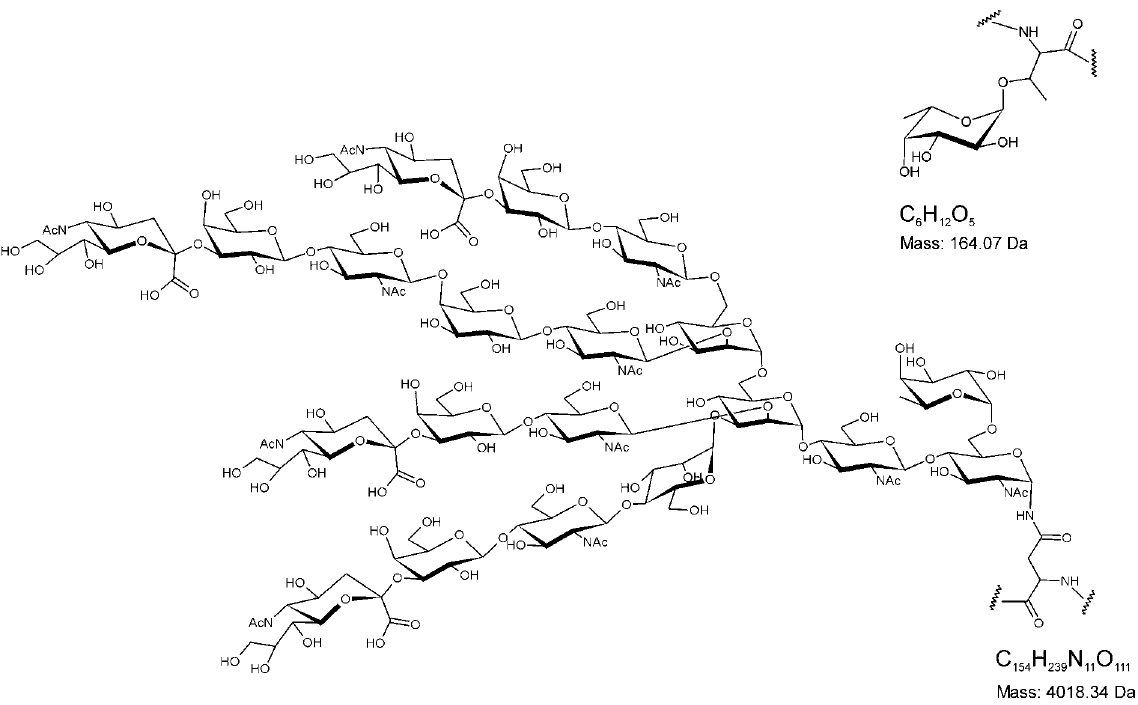
Figure 1 Glycosylation as post-translational modification ranges from a single fucose residue (top) to an N -acetyllactosamine repeat containing tetrasialylated tetraantennary core-fucosylated complex type N-glycan (bottom). modes (25), which suggests that the O-glycosylation is not random at all and that its fine-tuning is not yet